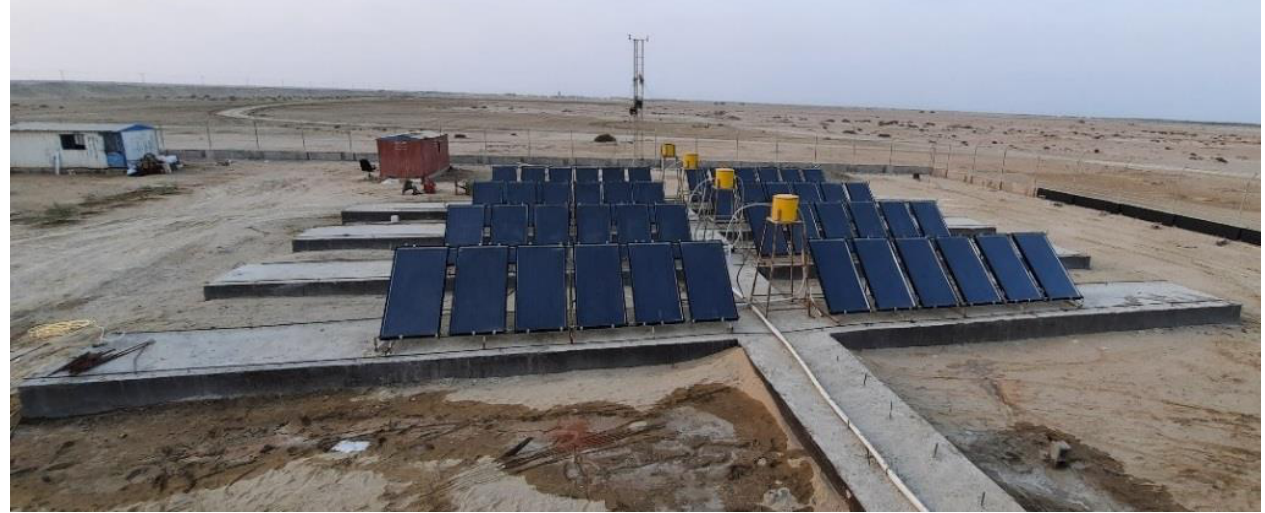
Figure 5. Solar farm in front of the seawater greenhouse.